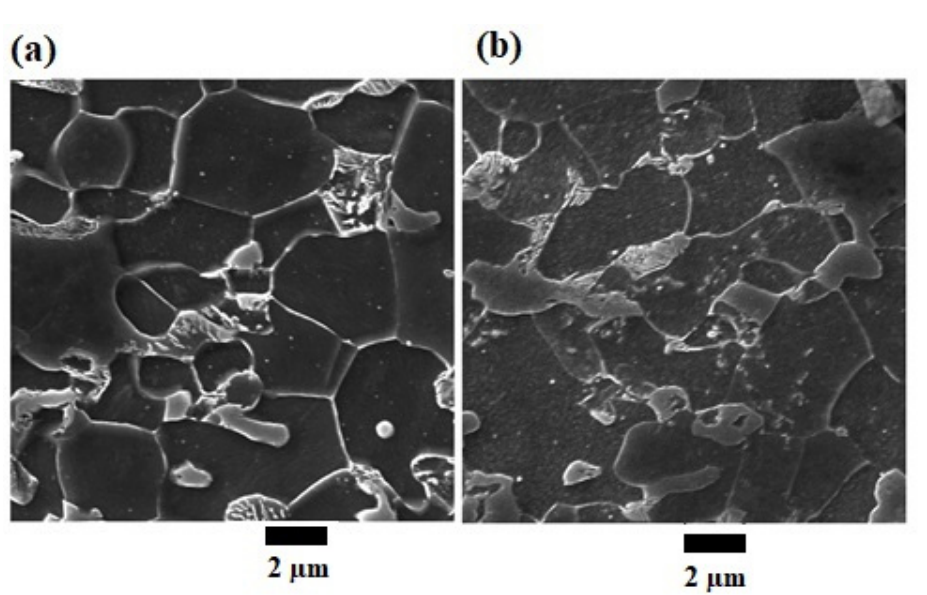
Figure 1. ( a ) and ( b ) SEM microstructure at the surface of as-received API 5L X70 steel. Figure 1. ( a , b ) SEM microstructure at the surface of as-received API 5L X70 steel.